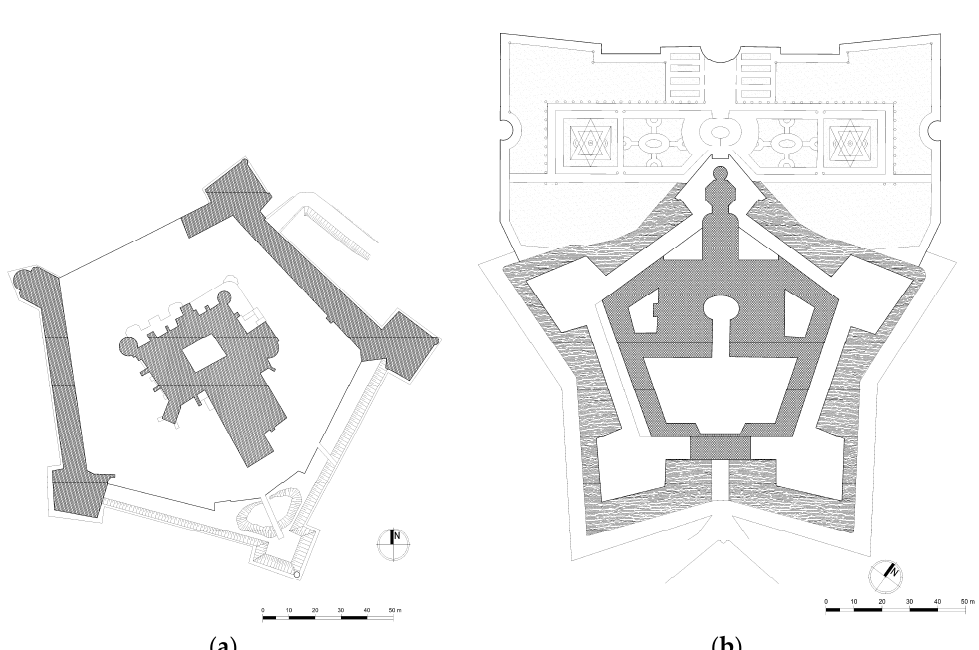
Figure 14. ( a ) Nowy Wi ś nicz: Lubomirscy’s residence—palace plan with fortifications; created by authors; ( b ) Ujazd: Krzy ż topór, Ossoli ń scy’s residence—palace plan with fortifications; created by authors.